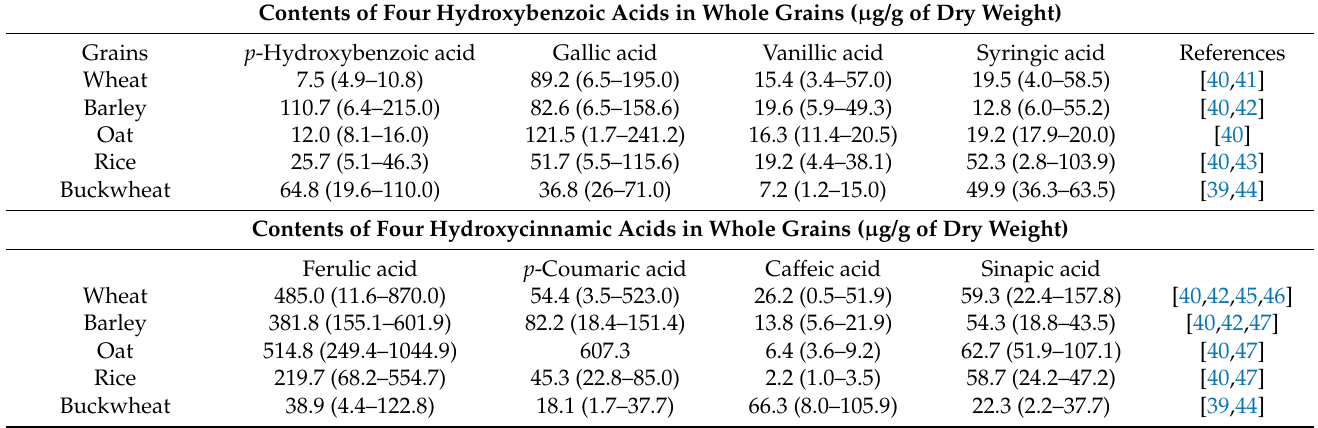
Table 2. Review of four hydroxybenzoic acids and four hydroxycinnamic acids in five whole grains. Contents of Four Hydroxybenzoic Acids in Whole Grains ( µ g/g of Dry